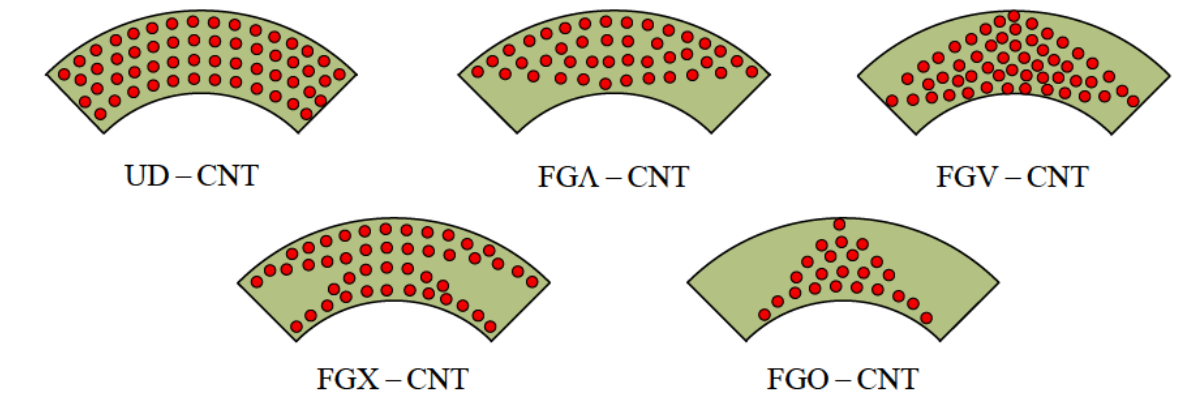
Figure 2: Distribution types of CNTs of FG-CNT reinforced composite panels.